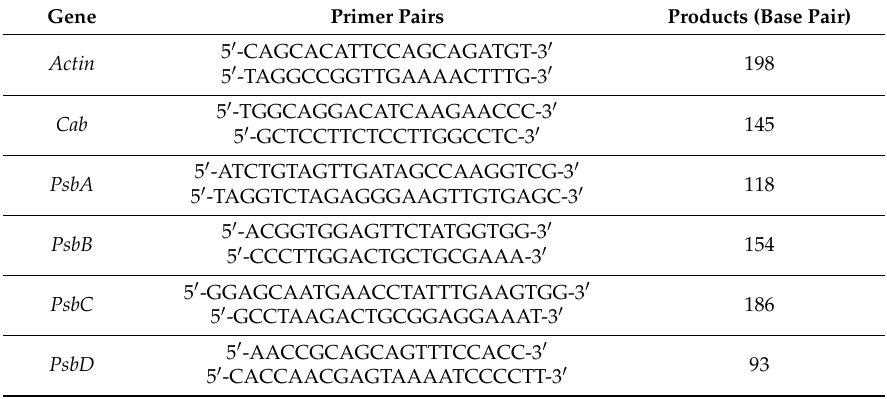
Table 1. Sequence of primers for ACTIN-1 and genes used for quantitative real-time